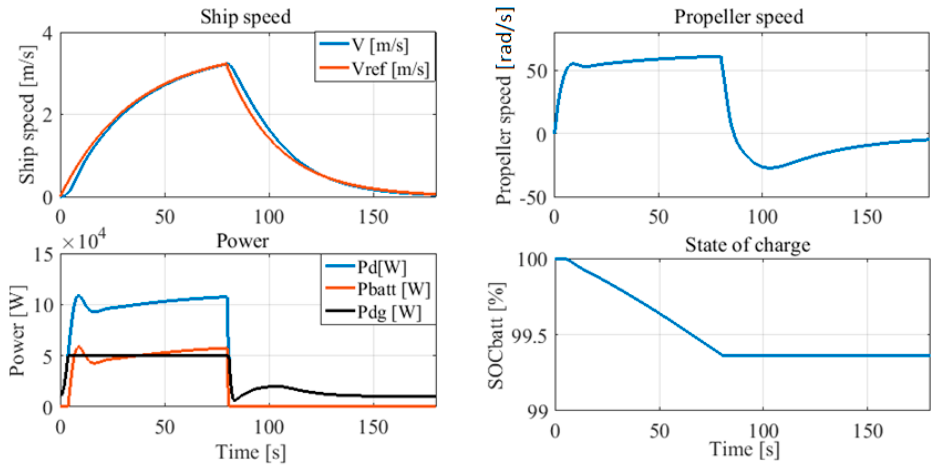
Figure 10. One cycle Simulation results for the SH_DG-Bat structure.